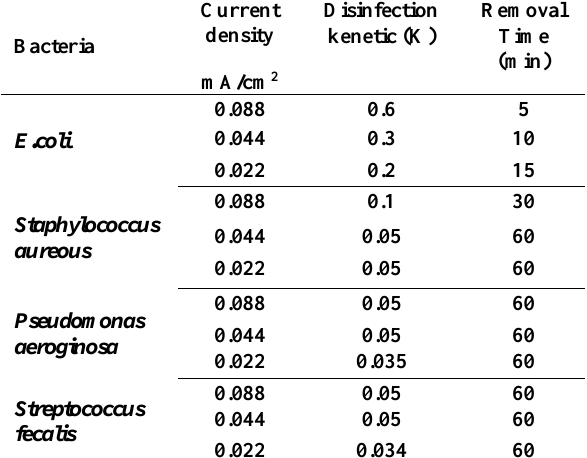
Table 2 Obtained results of K for different examined bacteria in the electrochemical disinfection